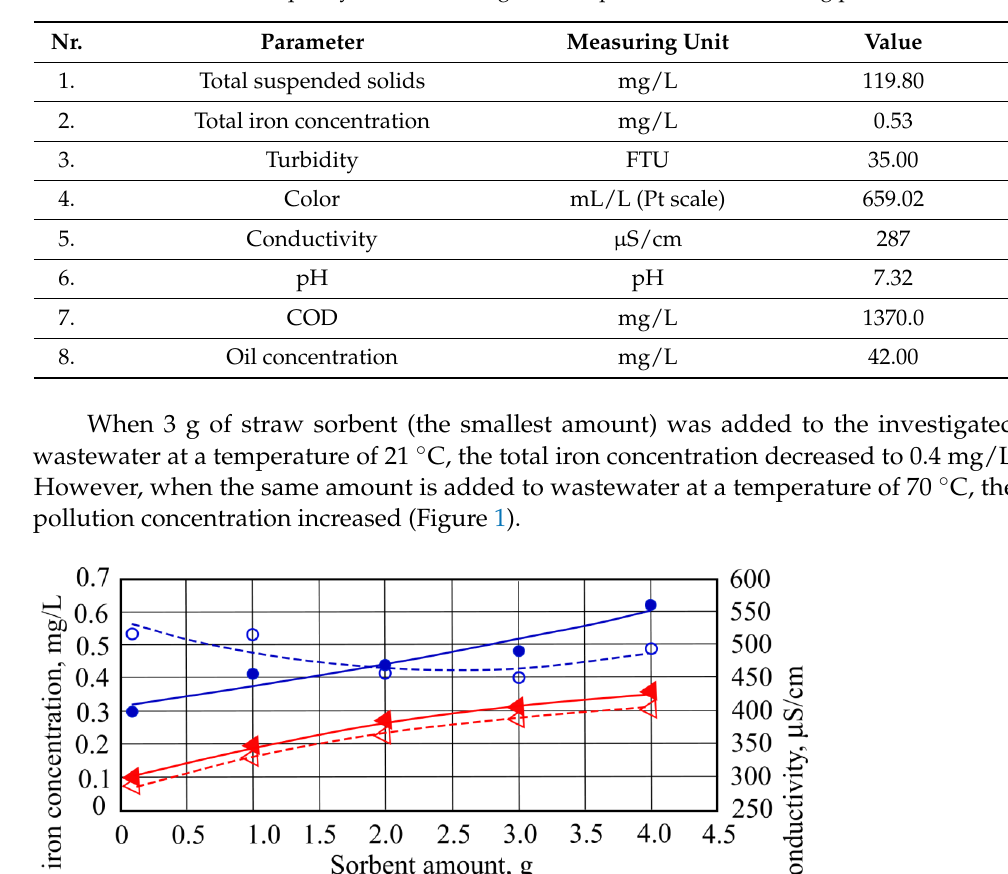
Table 1. The wastewater quality data of investigated samples from tank washing processes.